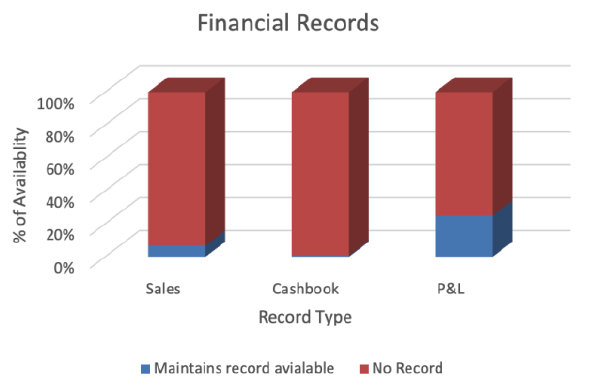
Figure 2: Financial Records